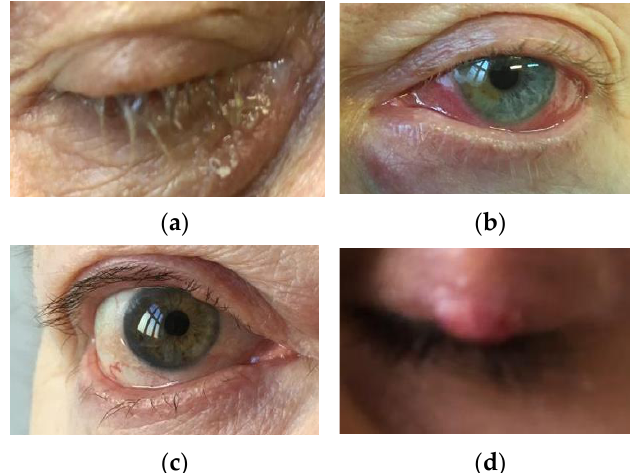
Figure 2. Ocular and blepharal manifestations of demodicosis in adults (authors’ own archive): ( a ) Patient with scales on the eyelashes, eyelid changes (dry, reddened skin lesion); ( b ) patient with conjunctivitis and slight swelling of the upper and lower eyelids; ( c ) patient with conjunctivitis, falling eyelashes (eyelash loss) on the lower eyelid and the beginning of abnormal growth of eyelashes on the upper eyelid; ( d ) patient with a chalazion in the course of demodicosis.